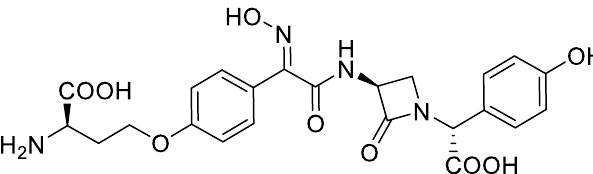
Figure 1. Nocardicin A, a representative β-lactam antibiotic of the nocardicins